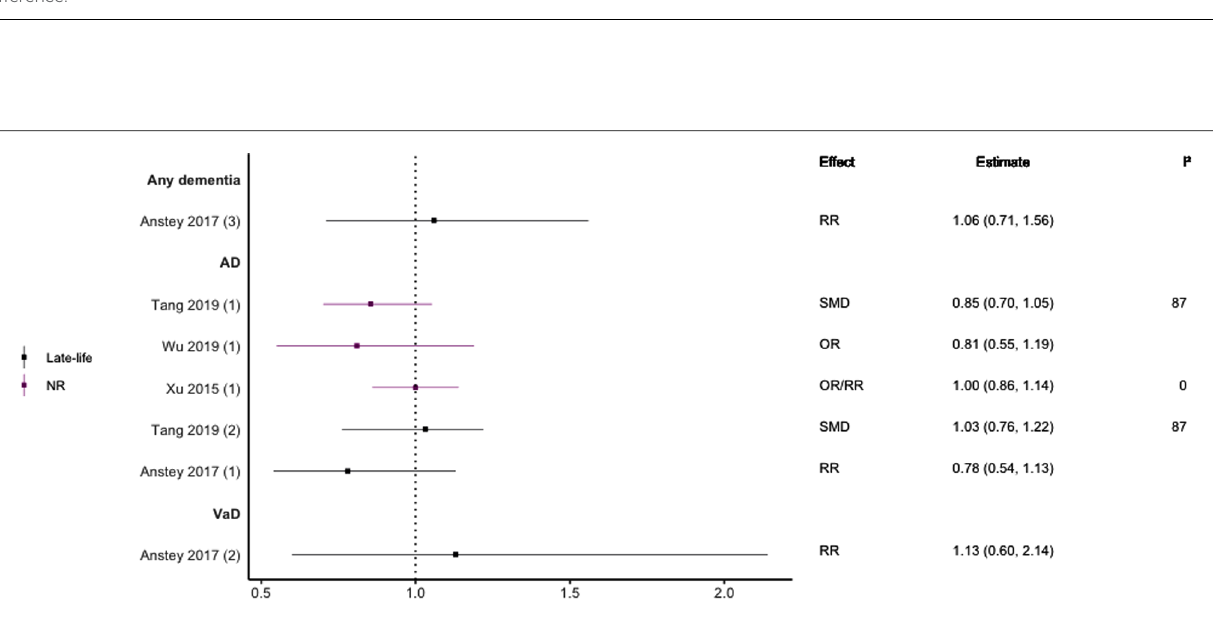
FIGURE 9 Effect estimates of meta-analyses reporting an association between HDL-C and dementia. The vertical line represents no effect, with different colours conveying age strati fi cation. To note, Xu et al. treated ORs as approximates to RRs, as such, violations of this assumption may have implications for the comparability of ORs and RRs, meaning that interpretation of these pooled estimates should be done cautiously. Moreover, SMDs have been converted to (cid:1) (cid:3) p (cid:2) SMD . AD, Alzheimer ’ s disease; OR, odds ratio; RR, risk ratio; SMD, standard mean difference; VaD, vascular dementia. approximate ORs using OR ¼ exp 3